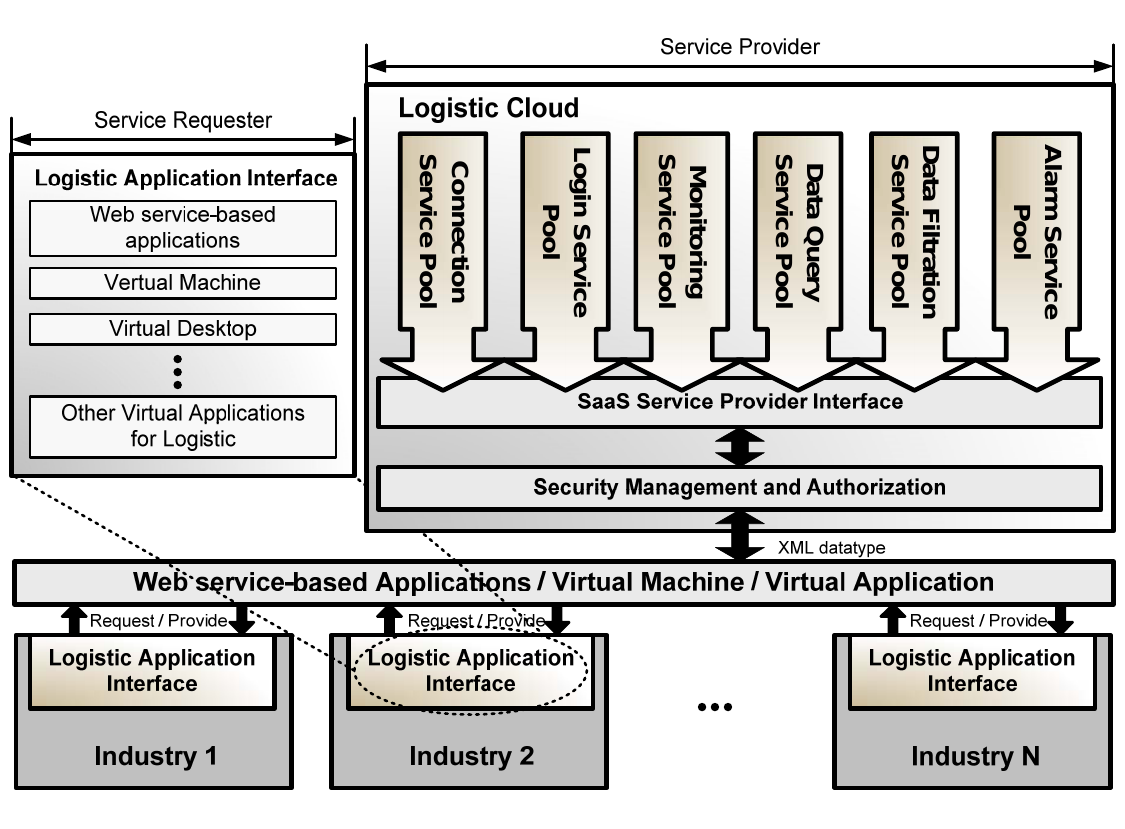
Figure 10. Service access model.